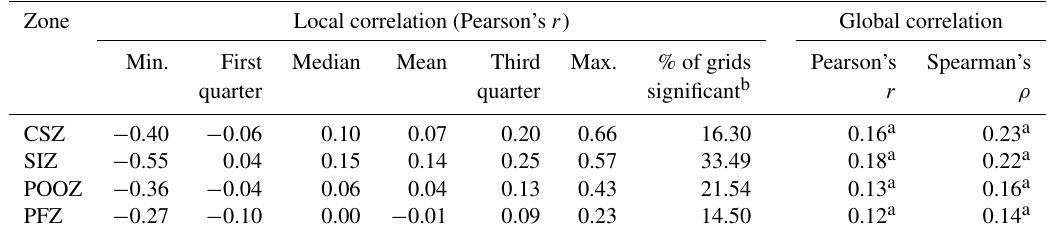
Table 3. Correlation between annual total primary production and iceberg frequency. Zone Local correlation (Pearson’s r ) Global correlation Min. First Median Mean Third Max. % of grids Pearson’s Spearman’s quarter quarter significant b r ρ CSZ − 0.40 − 0.06 0.10 0.07 0.20 0.66 16.30 0.16 a 0.23 a SIZ − 0.55 0.04 0.15 0.14 0.25 0.57 33.49 0.18 a 0.22 a POOZ − 0.36 − 0.04 0.06 0.04 0.13 0.43 21.54 0.13 a 0.16 a PFZ − 0.27 − 0.10 0.00 − 0.01 0.09 0.23 14.50 0.12 a 0.14 a